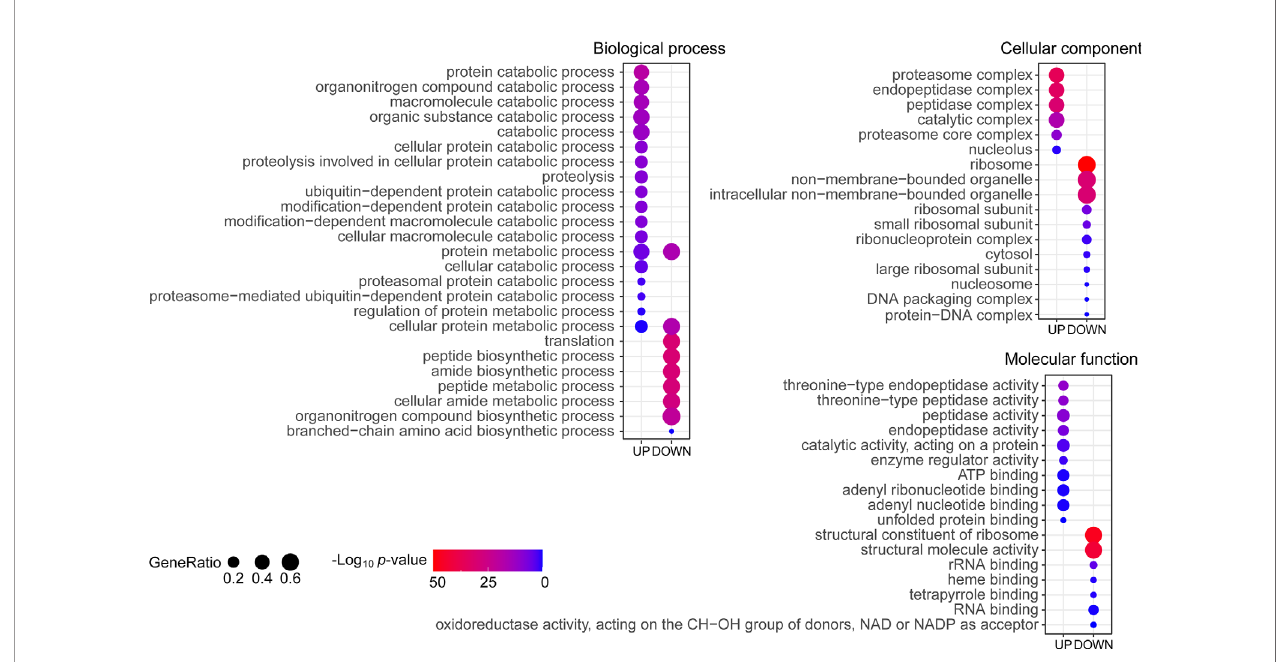
FIGURE 3 | Gene Ontology (GO) enrichment of differentially expressed proteins under copper (Cu) stress. The proteins were annotated with subcategory terms in the three GO categories: biological processes, cellular compartments, and molecular functions. For each category, a two-tailed Fisher ’ s exact test was used to assess the enrichment of the differentially expressed protein against all identi fi ed proteins. The GO subcategories with a p -value <0.05 were considered signi fi cantly enriched and shown in the fi gure. The size of the bubbles represents the proportion of differentially expressed proteins in this subcategory among the total number of proteins in the corresponding